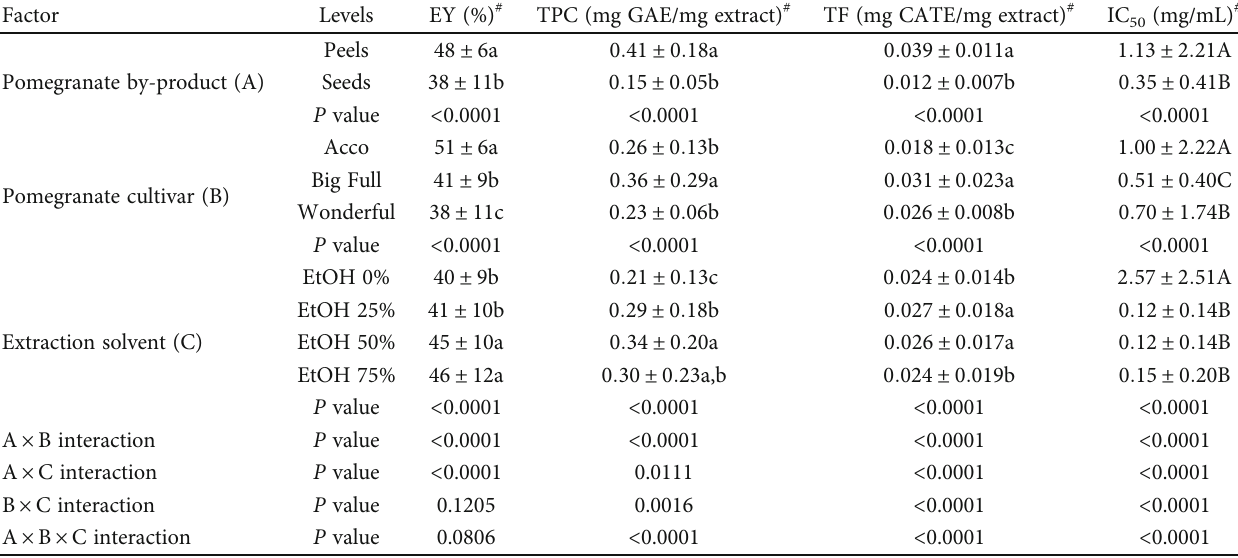
Table 4: Three-way ANOVA: in fl uence of pomegranate by-product (peels and seeds), pomegranate cultivar (Acco, Big Full, Wonderful), and ethanol/water extraction solvent (0%, 25%, 50%, and 75% EtOH, v/v) on the extraction yield (EY), total phenolic compounds (TPC), total fl avonoids (TF), and antioxidant activity (AA expressed as IC 50